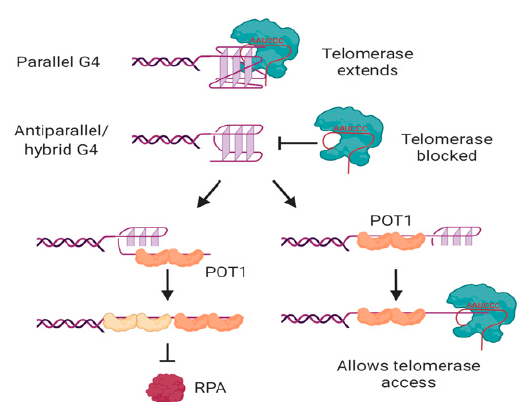
Figure 5. Interactions of telomerase, POT1 and RPA with human telomeric G-quadruplexes. Telomerase can bind and extend parallel, but not antiparallel or hybrid, G-quadruplexes. POT1 binds to antiparallel or hybrid G-quadruplexes through a mechanism in which G4 unfolding precedes “trapping” of the unfolded DNA by POT1. The two OB folds of each POT1 molecule bind to consensus binding site TTAGGGTTAG; sequential binding of two POT1 molecules therefore coats the 4-repeat telomeric DNA (left). Although RPA also has the ability to unwind G-quadruplexes, POT1 competes with this activity. If binding of POT1 occurs at the 5 (cid:48) region of the DNA, the 3 (cid:48) tail can form a substrate for telomerase (right). Not shown is POT1’s binding partner TPP1, which also influences G4 unwinding dynamics and telomerase activity. See text for details and references. Figure created with